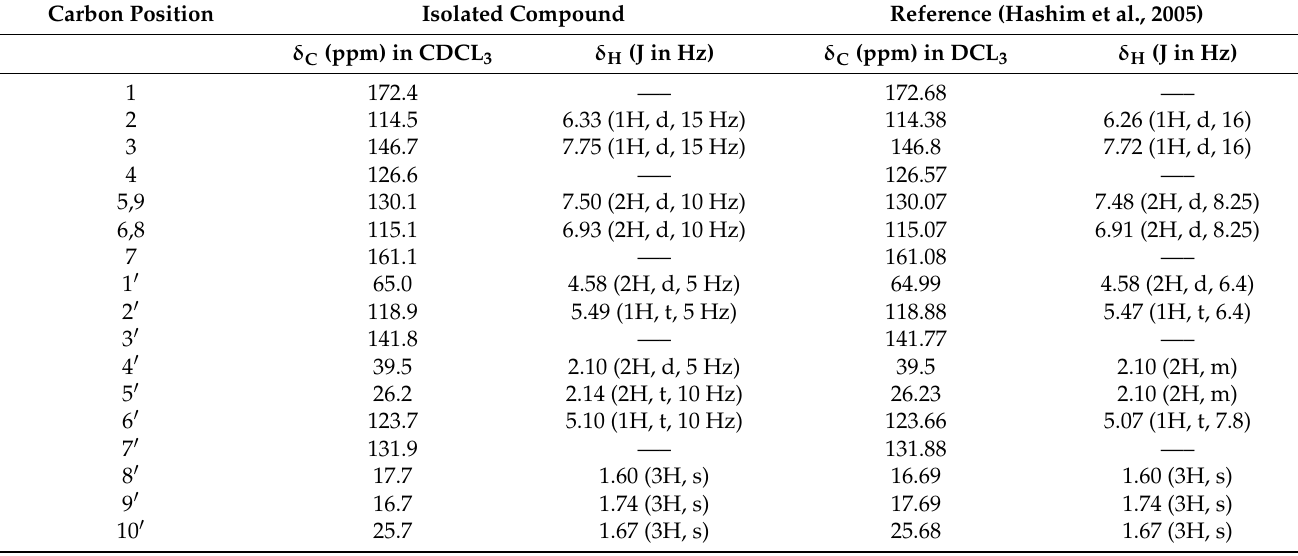
Table 2. 1 H NMR and 13 C NMR data for the isolated